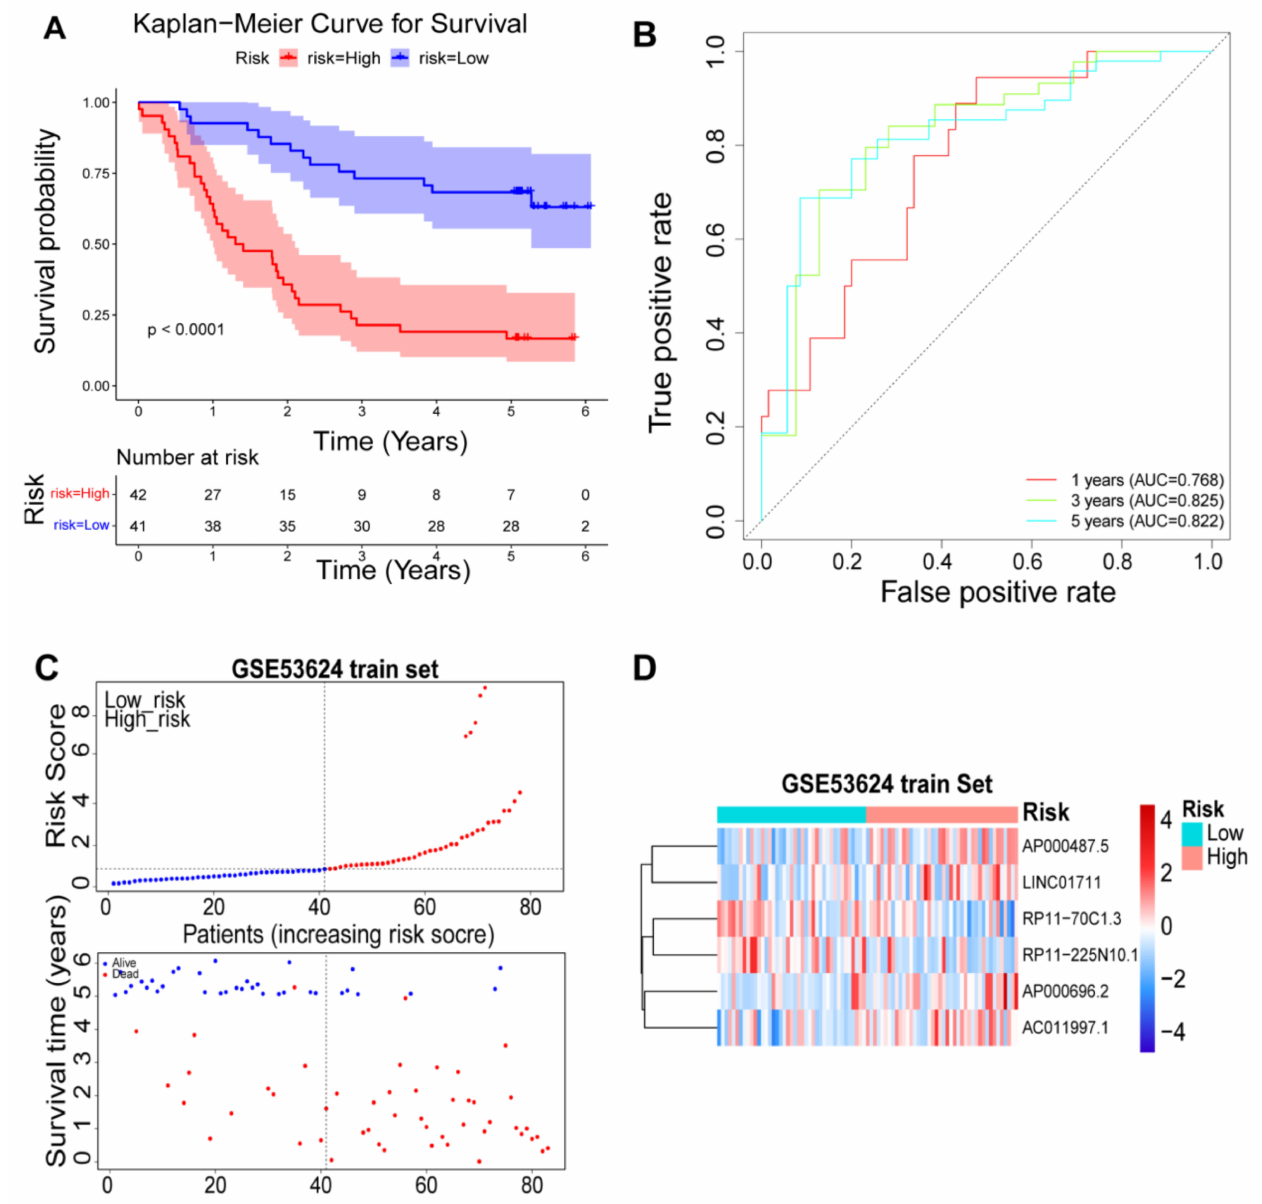
Figure 4. Prognostic values and predictive accuracy of the six-DEARlncRNA. K-M survival curve ( A ); time-dependent ROC curve ( B ); risk score distribution (( C ), above ); survival overview (( C ), below ); and heatmap ( D ) for patients in the GSE53624 training set assigned to high- and low-risk groups based on the risk